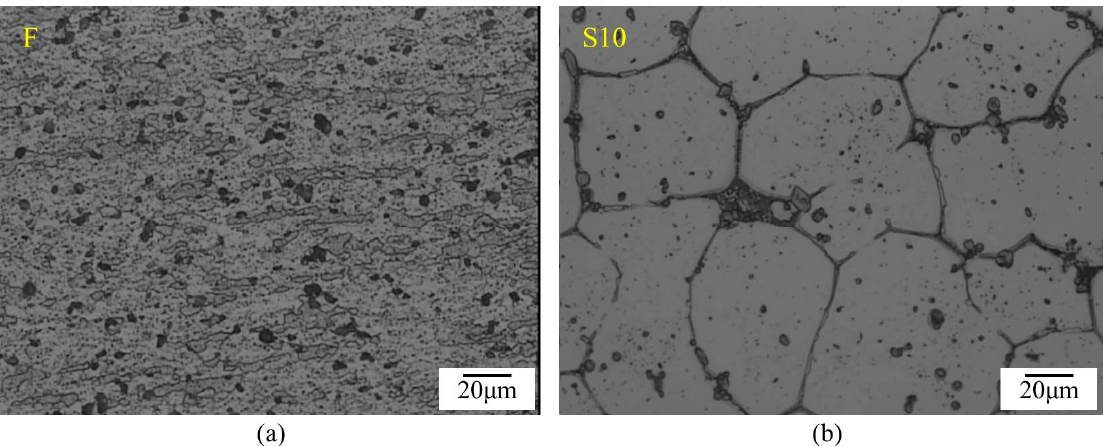
Figure 4. Microstructures of ( a ) as ‐ extruded alloys (F) and ( b ) TS ‐ SIMA alloys (S10).